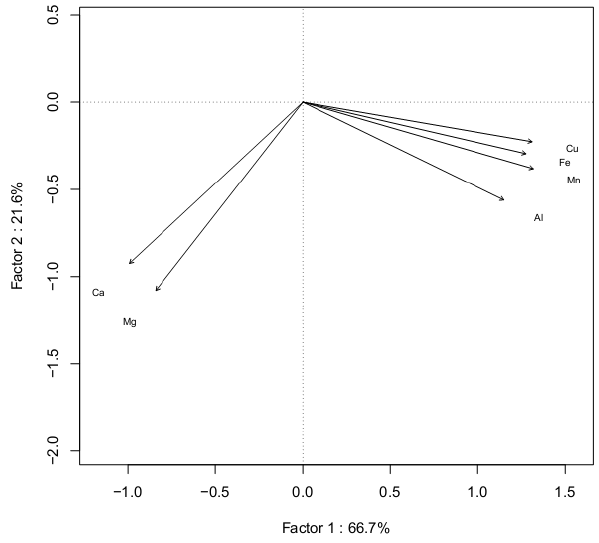
Fig. 6 Figure 6. Projection of six elemental variables for principle com- ponent analysis factors one and